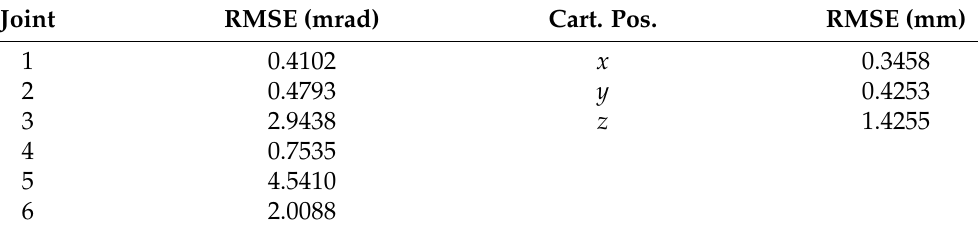
Table 2. Linear motion task tracking root mean square error